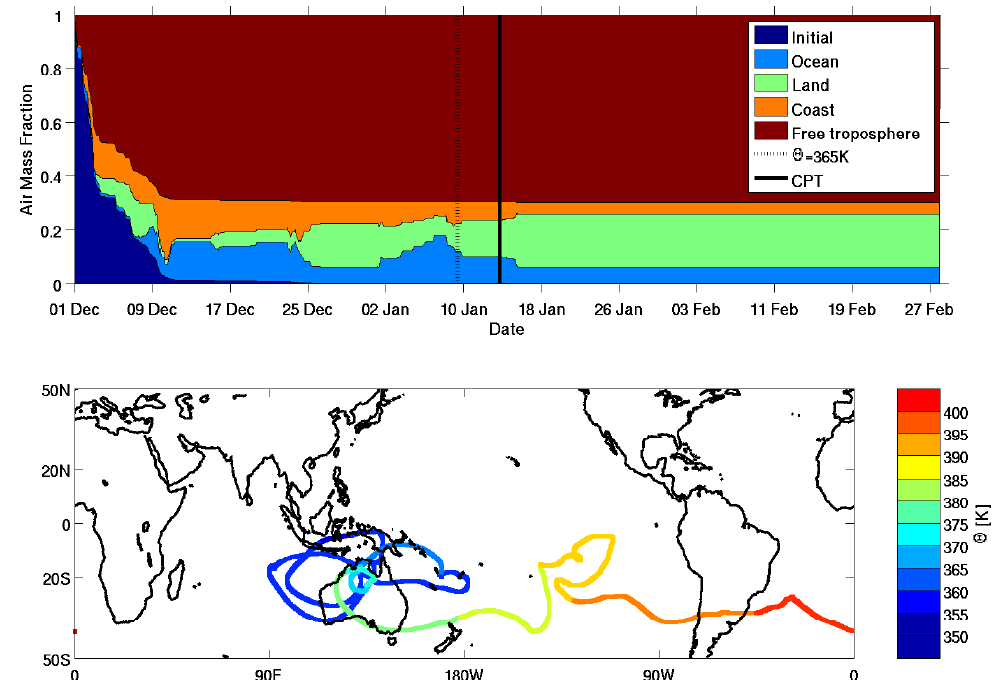
Fig. 4. How convection alters the airmass origin for a trajectory in DJF, 2000 is displayed in the upper panel ( ζ , the BL component of convective outflow is set at 30%). Where 2 = 365K and the CPT occur are indicated with the dashed and solid lines, respectively. The lower panel maps the trajectory path, with the colour designating the potential temperature of the